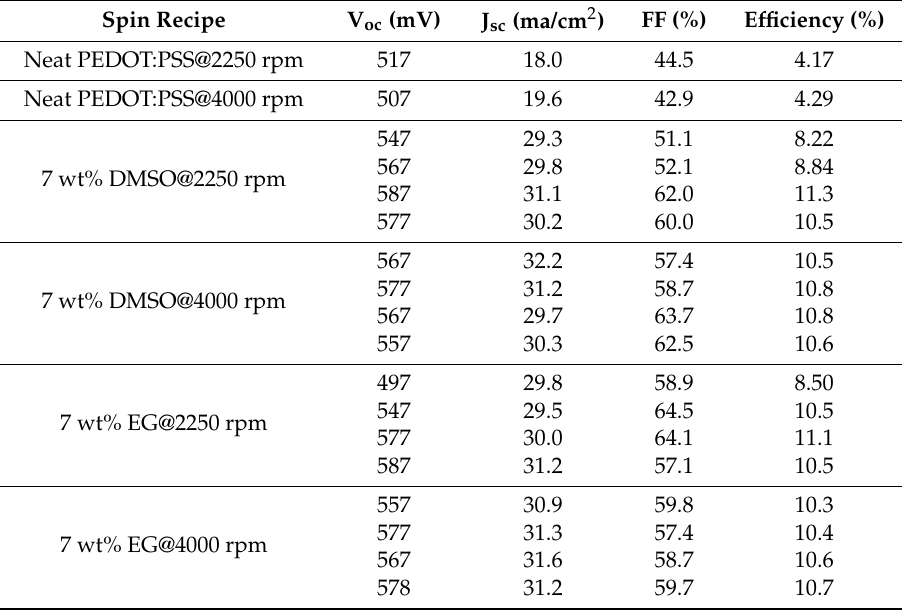
Table 3. Performance of photovoltaic devices fabricated with different PEDOT:PSS recipes. Spin